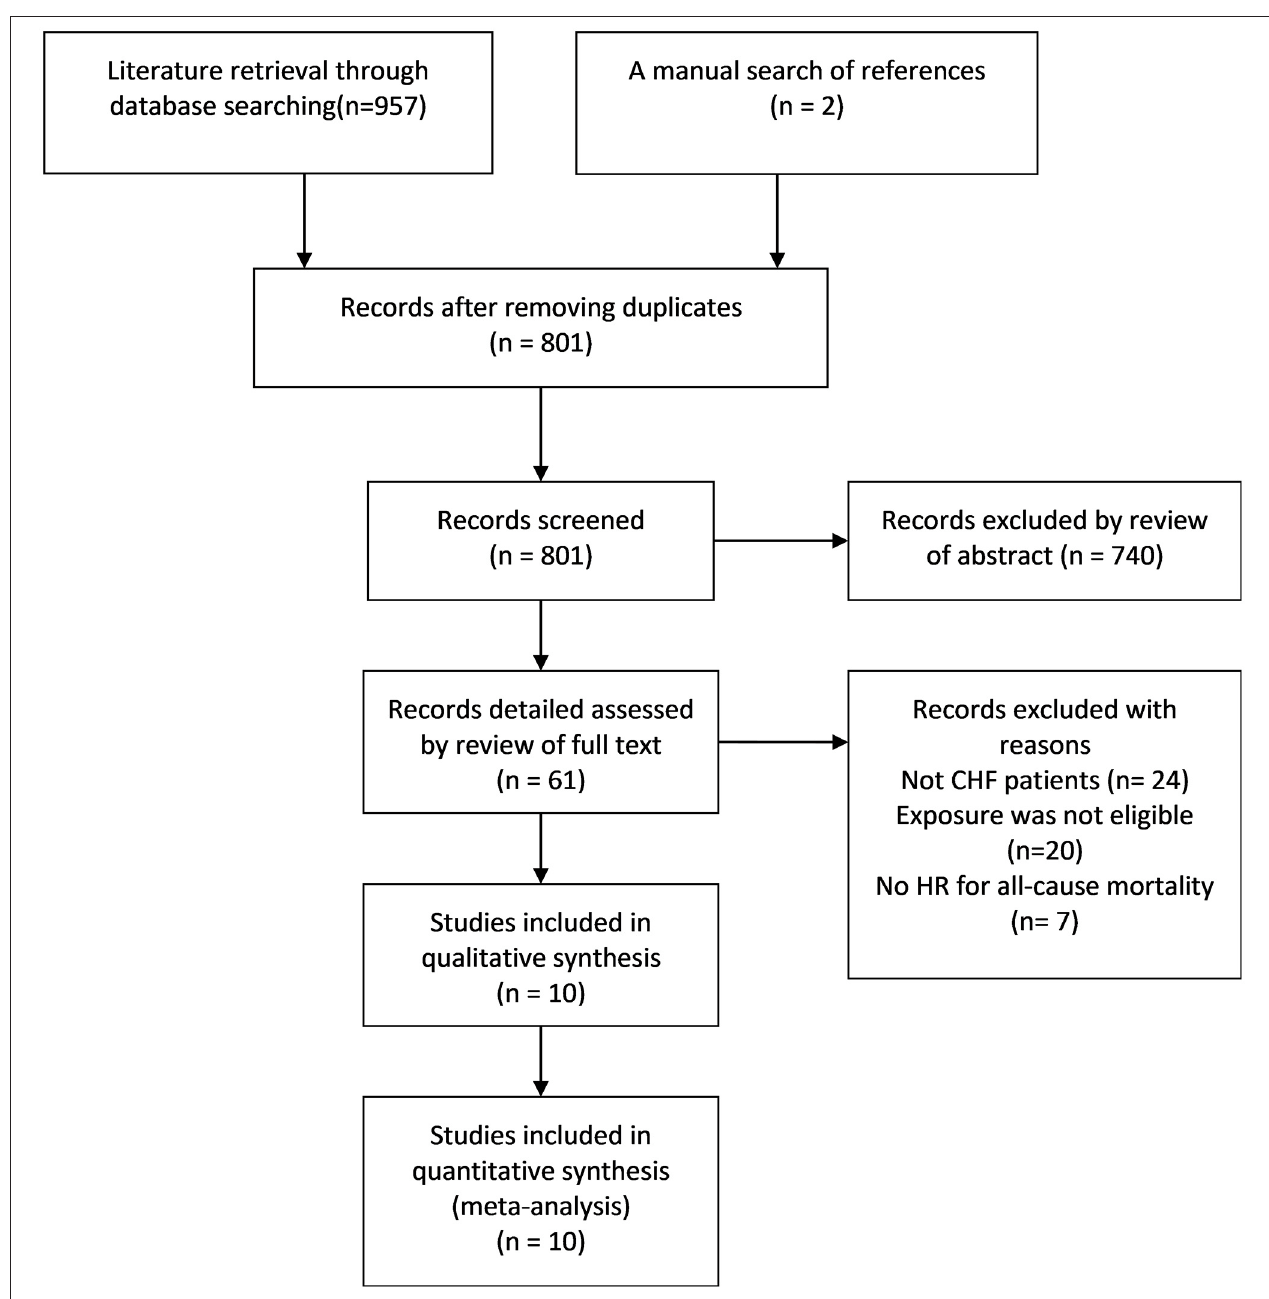
FIGURE 1 | Flow chart of article inclusion and exclusion